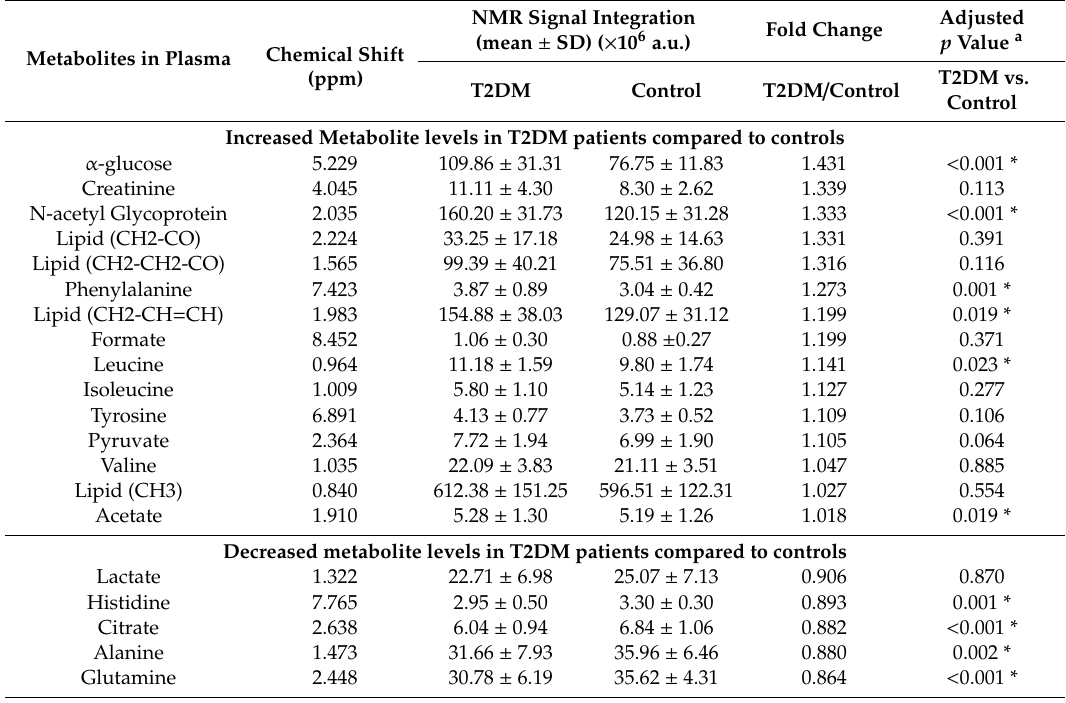
Table 3. Metabolites changed in plasma samples from T2DM patients versus control